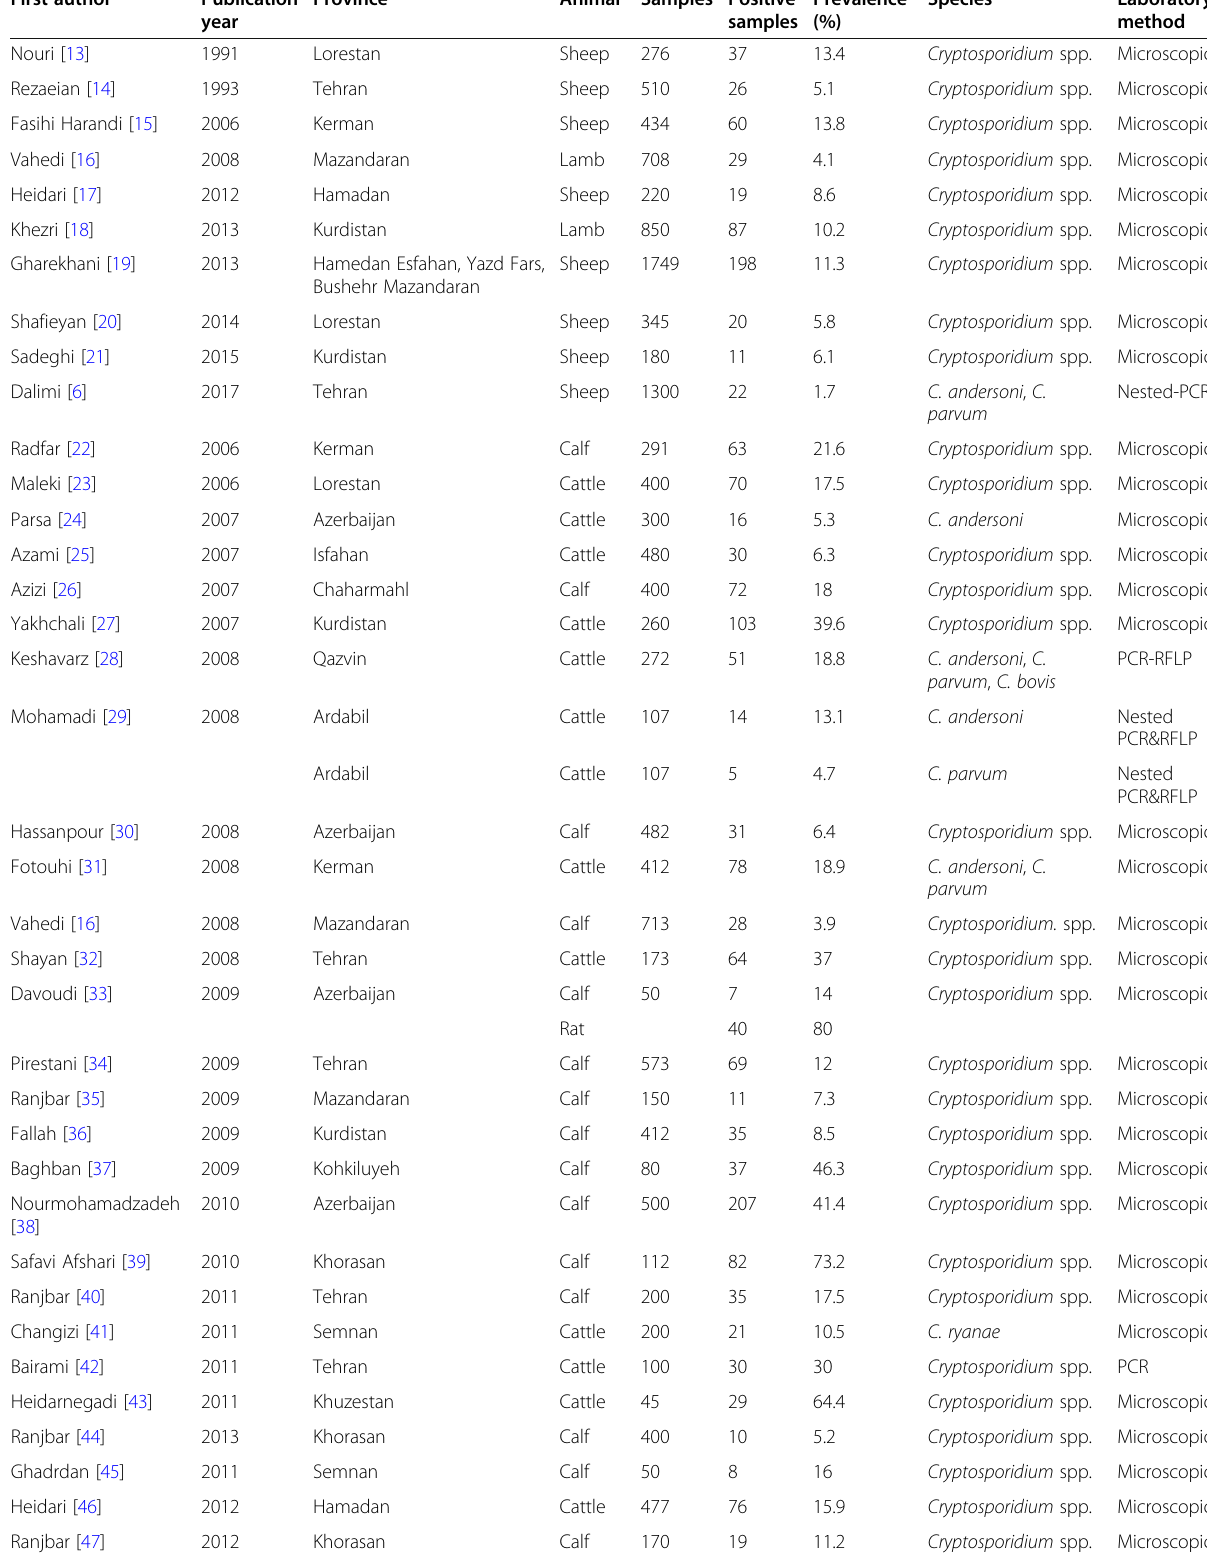
Table 1 Baseline characteristics of included